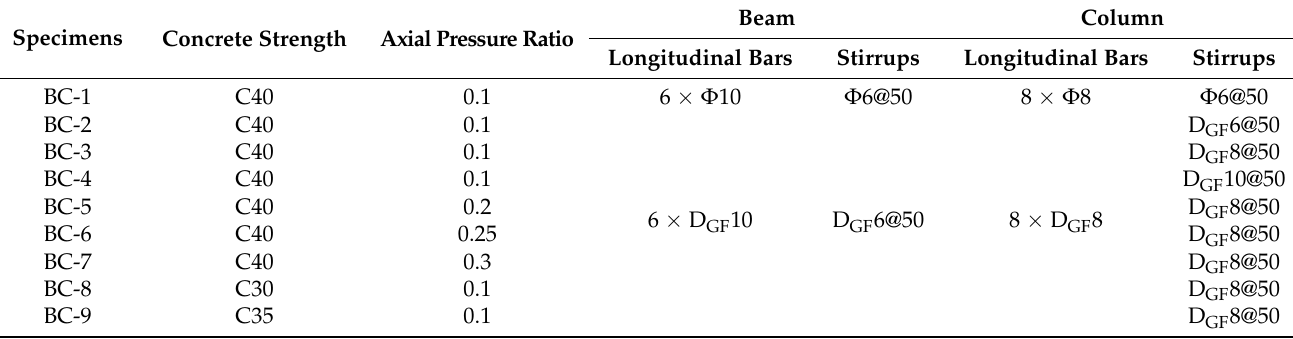
Table 5. Design characteristics of the test